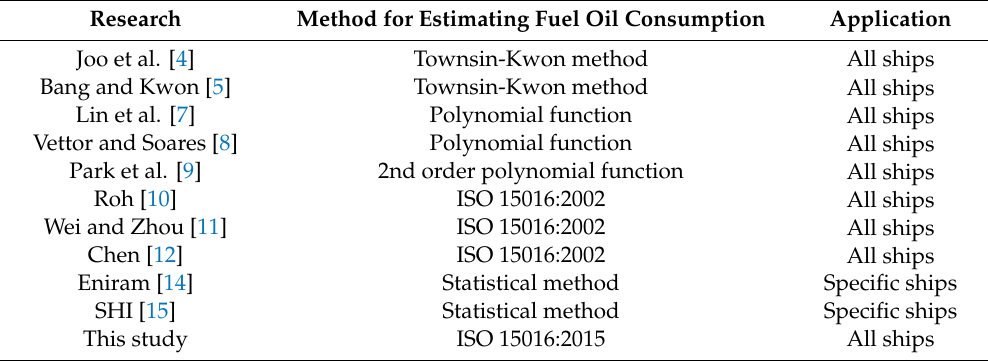
Table 1. Summary of related studies and comparison with this